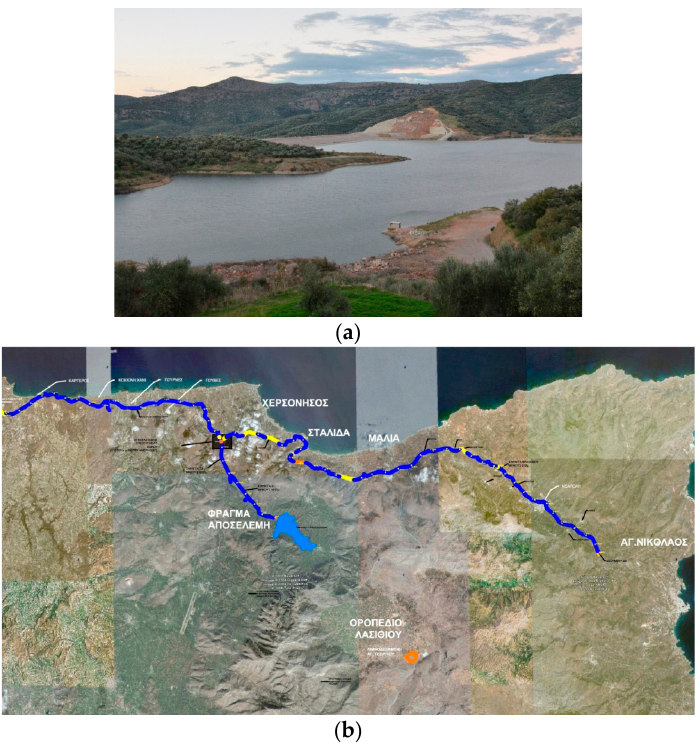
Figure 9. The Aposelemi dam: ( a ) general viewl and ( b ) Water Supply Network Iraklion–Chersonisos– Agios Nickolaos–Malia–Elounda–Neapolis. Agios